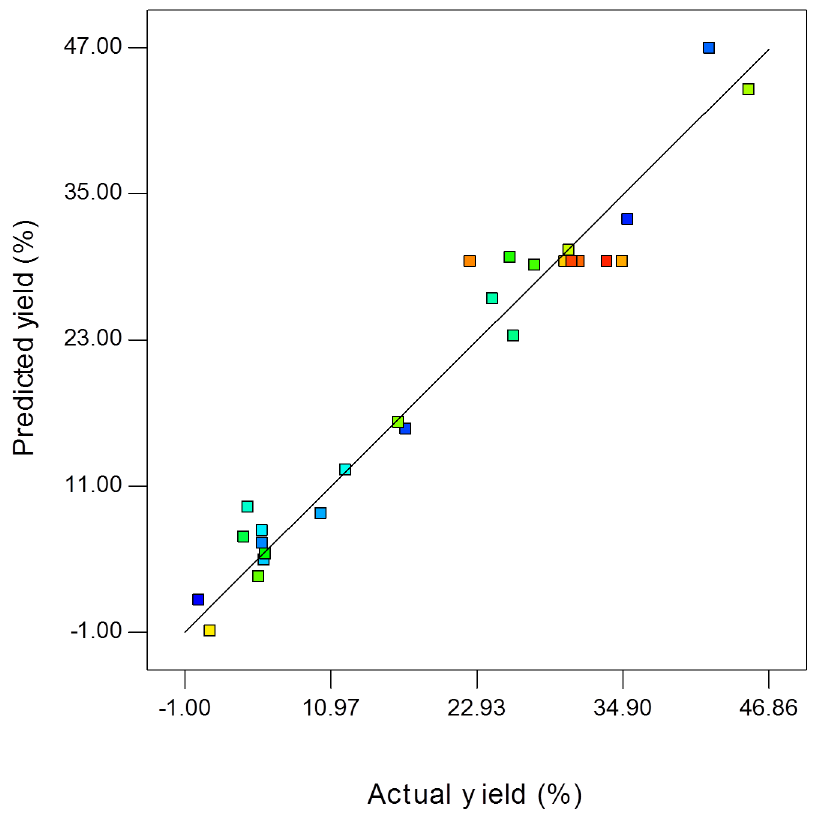
Fig 2. Correlation of actual and predicted values of yield by the response surface